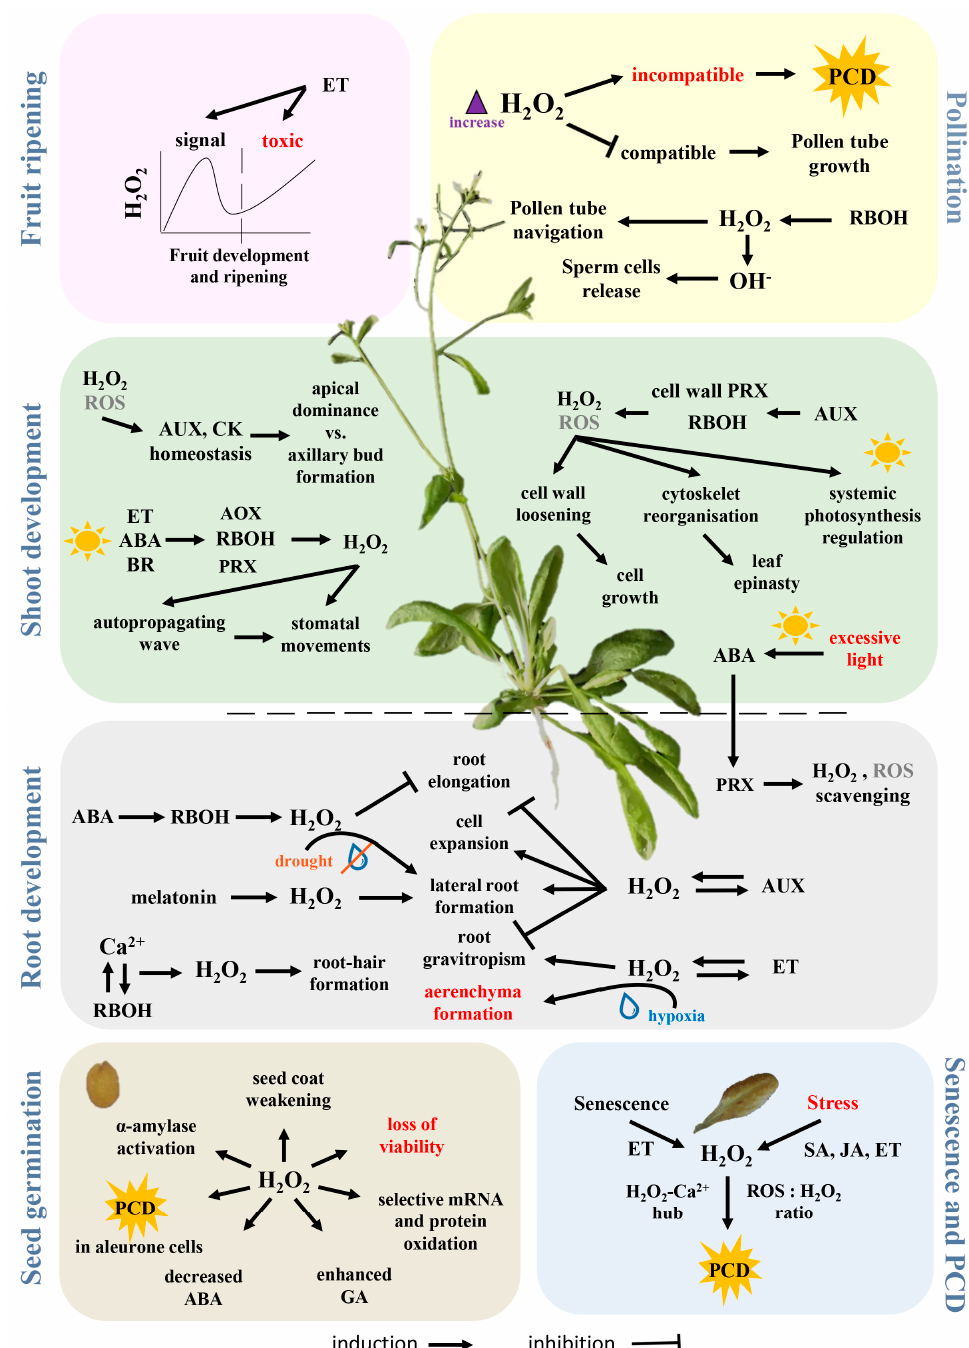
Figure 2. Hydrogen peroxide-mediated processes in plant growth and development. This figure